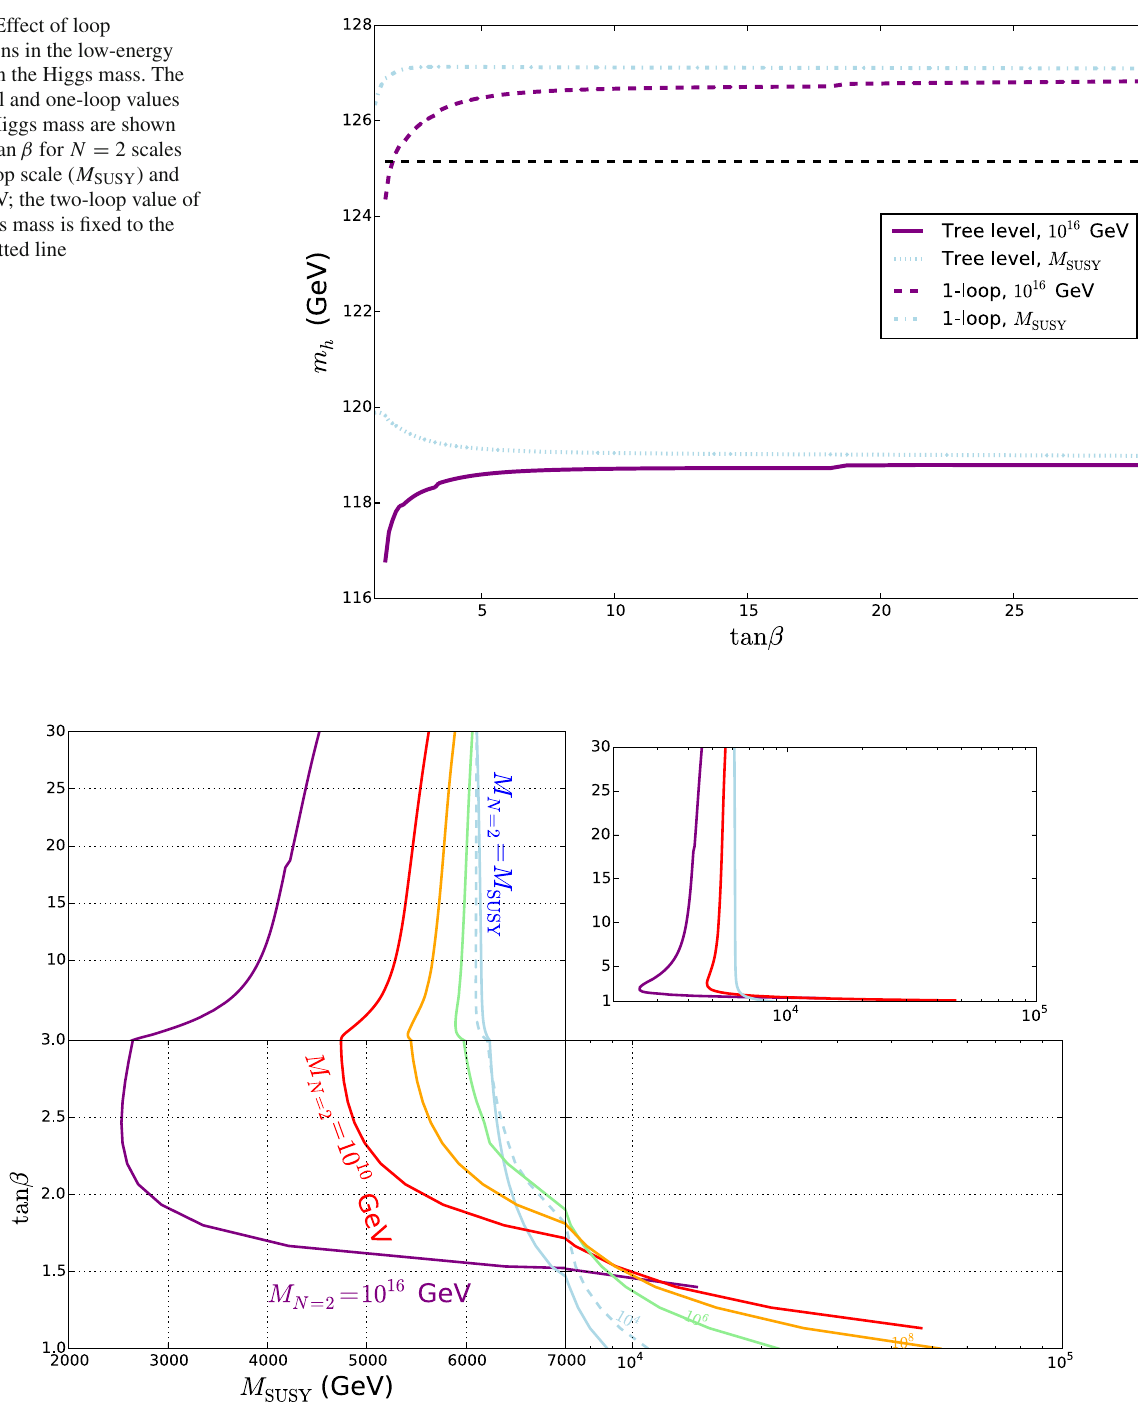
Fig. 6 SUSY scale that fits m h = 125 . 2 GeV against tan β . The cases M N = 2 = { M SUSY , 10 10 GeV , 10 16 GeV } are the solid lines in blue, red and purple respectively and are labelled in full; the cases M N = 2 = { 10 4 , 10 6 , 10 8 } GeV are respectively shown in blue dashed, solid green and solid orange curves and only labelled with { 10 4 , 10 6 , 10 8 } . Due to the large range of scales M SUSY values for small tan β and the lit-